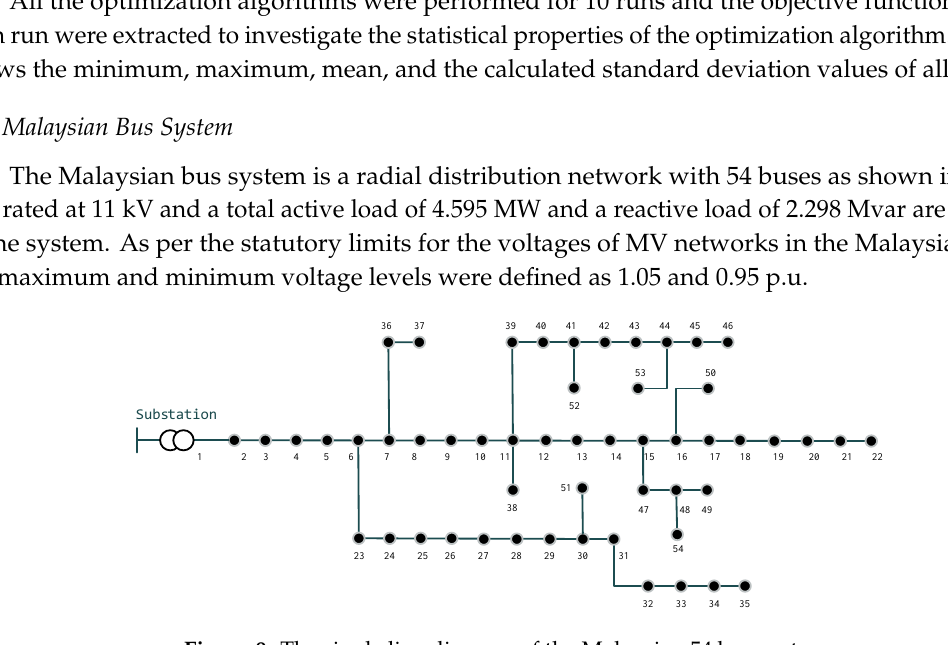
Table 5. Simulations results of optimal placement and sizing of DGs for PSO, and MLPSO algorithms—Malaysian 54 bus system.